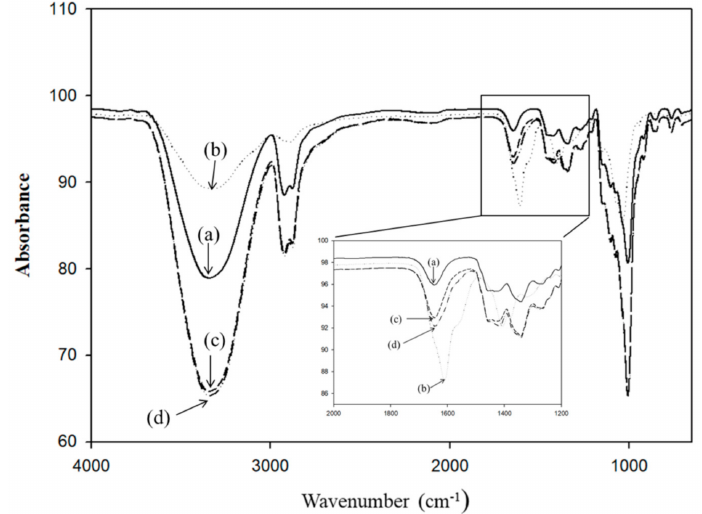
Figure 3. Fourier transform infrared spectra of hyaluronic acid-dextran (HA-Dex) hybrid hydrogel patches; (a) Dex, (b) HA, (c) Dex-HA (9.5:1.0), (d) Dex-HA